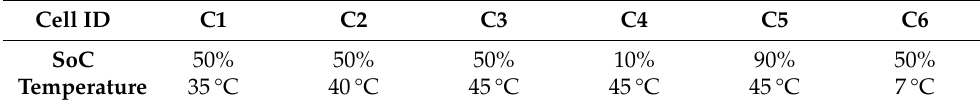
Table 2. Ageing conditions of Li-ion cells used. C1